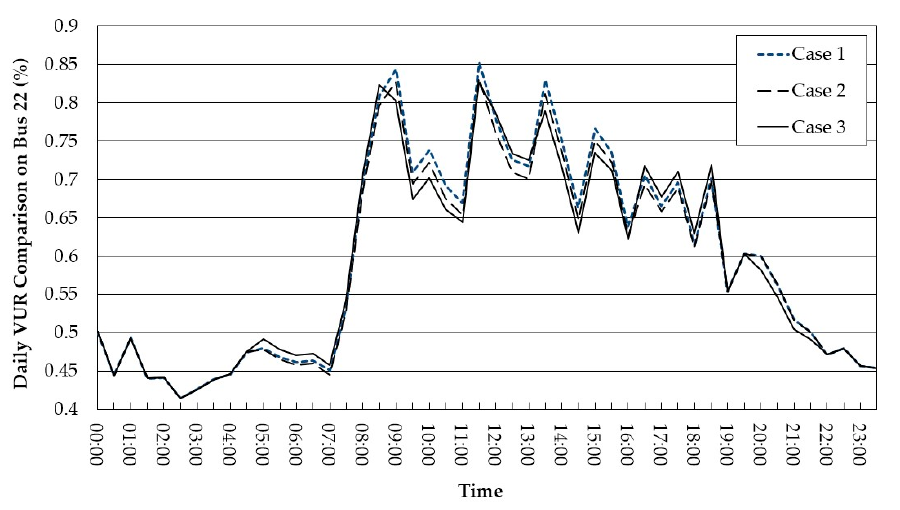
Figure 23. Daily VUR curve comparison on Bus 22.